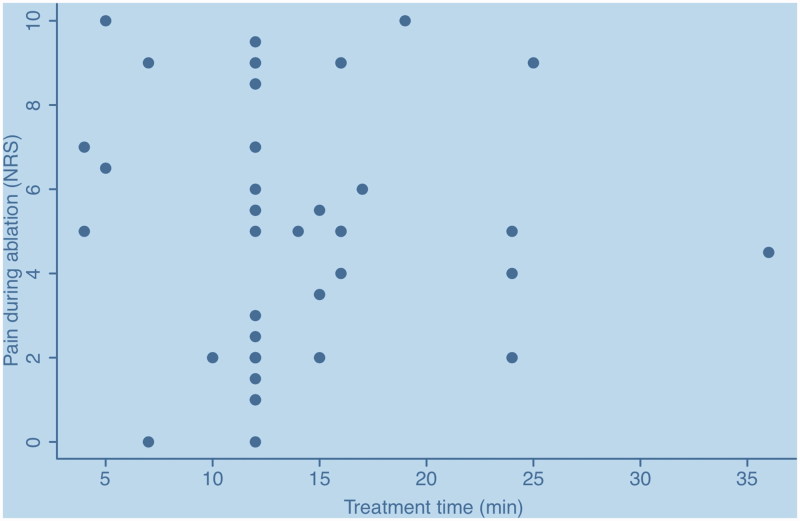
Treatment time did not correlate with experienced pain (R2=0.00007398, p = 0.9553).